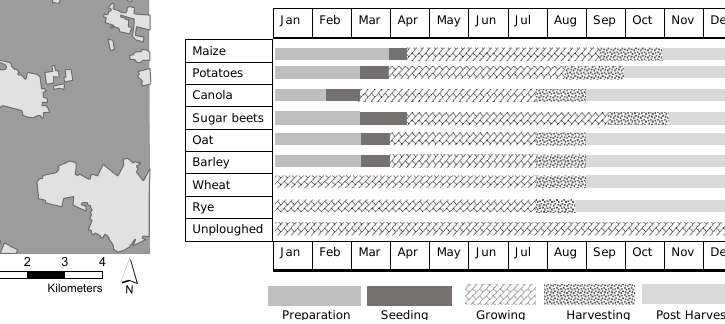
Figure 2. Location of the study site.